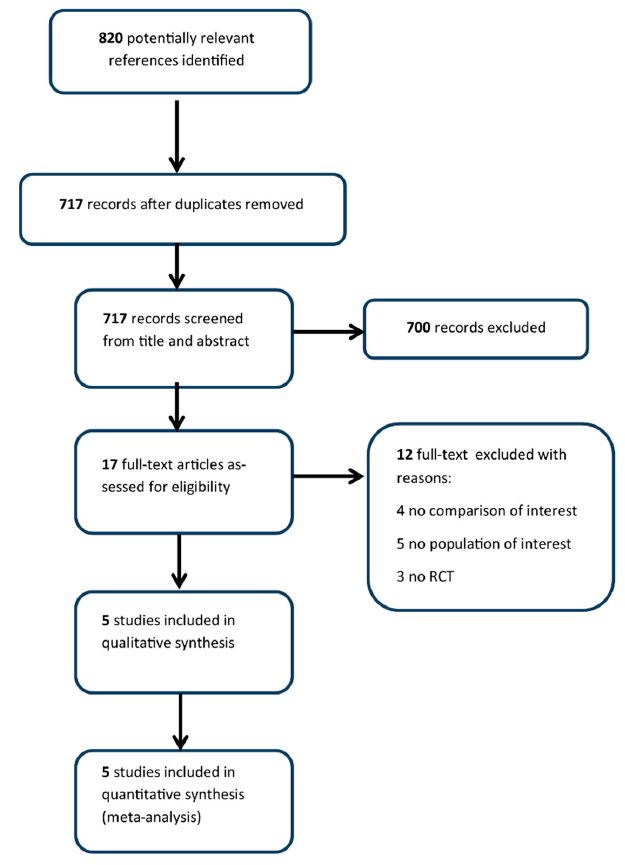
Figure 1. PRISMA (Preferred Reporting Items for Systematic Reviews and Meta-Analyses) flow chart. Table 1. Main characteristics of the studies considered for the GRADE assessment of the clinical question.